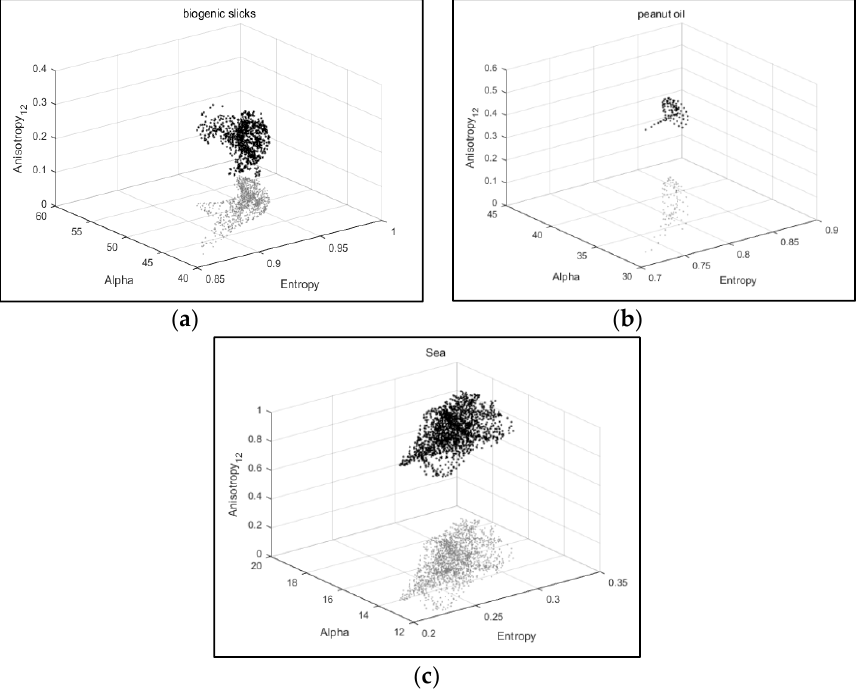
Figure 11. H /α/ A 12 plots for slick and seawater in case (2). The gray scatter points indicate the H /α plane; ( a – c ) correspond to biogenic slick sample, peanut oil sample and clean seawater sample, respectively.